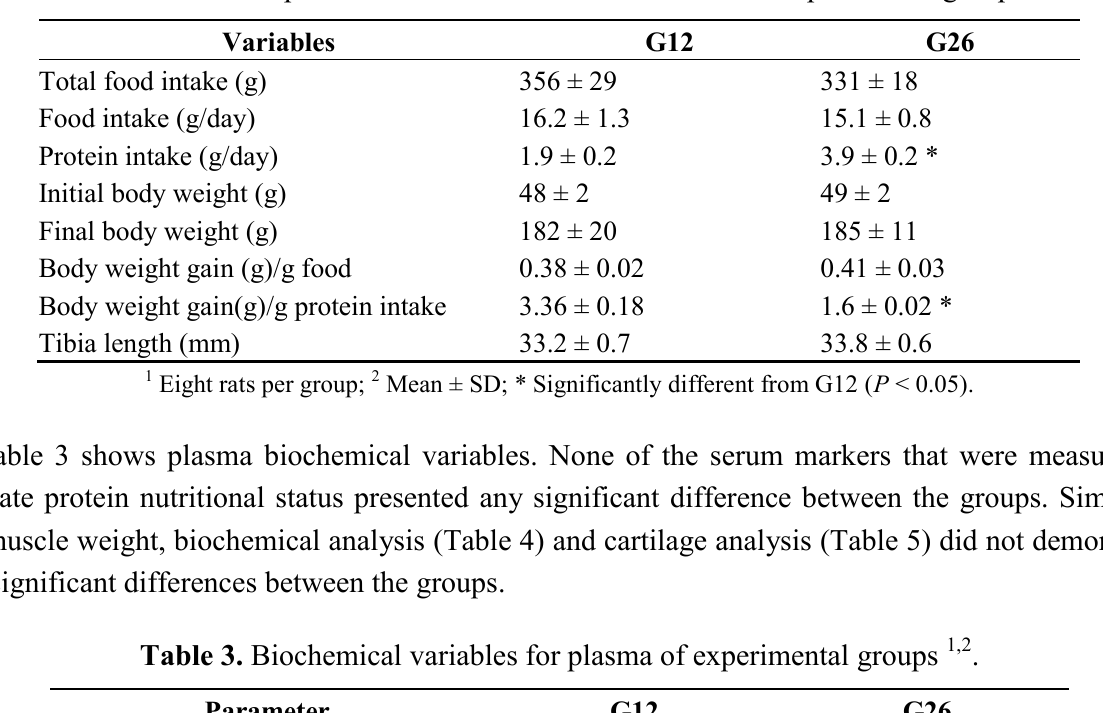
Table 2. Food and protein intake and biometric variables of experimental groups 1,2 .